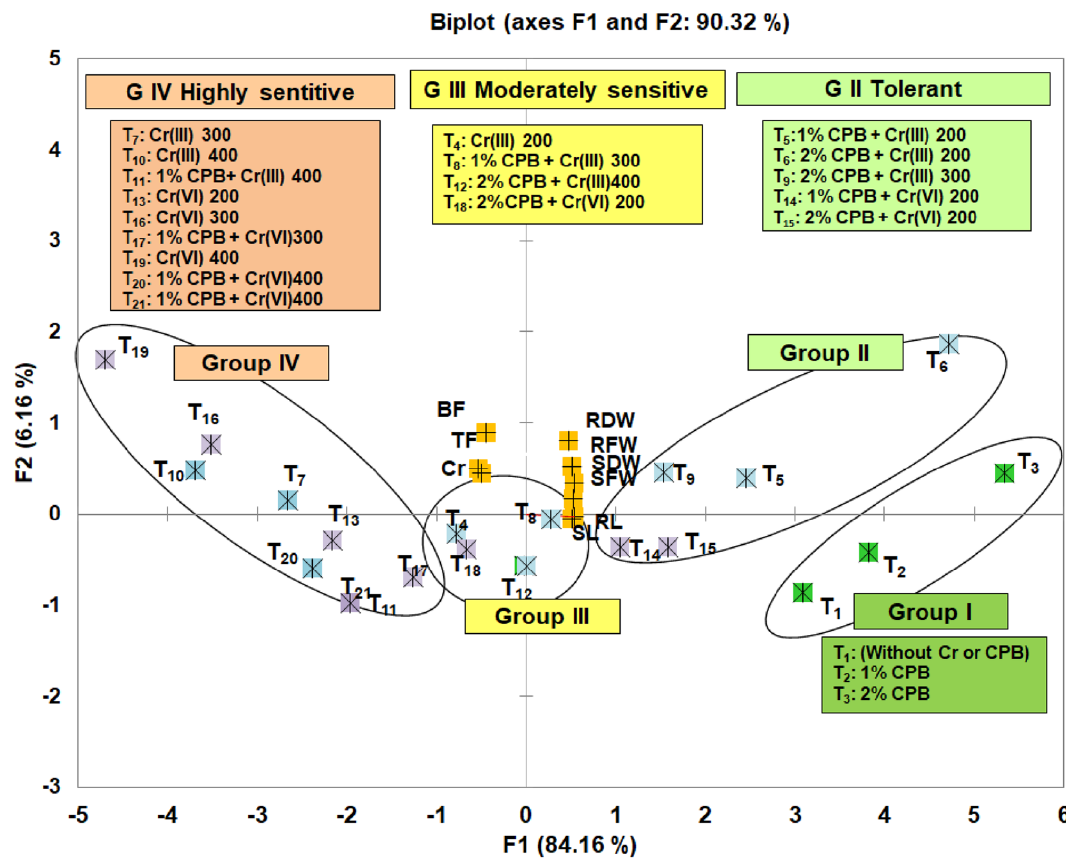
Figure 7. Principal component analysis of biophysical and metal accumulation attributes in 60-day-old tomato plants due to the effect of plant biomass of Cloncurry buffel grass (CPB), Cr(III), and Cr(VI). SL shoot length, RL root length, SFW shoot fresh weight, SDW shoot dry weight, RFW root fresh weight, RDW root dry weight, TF translocation factor, BF bioconcentration factor, Cr chromium